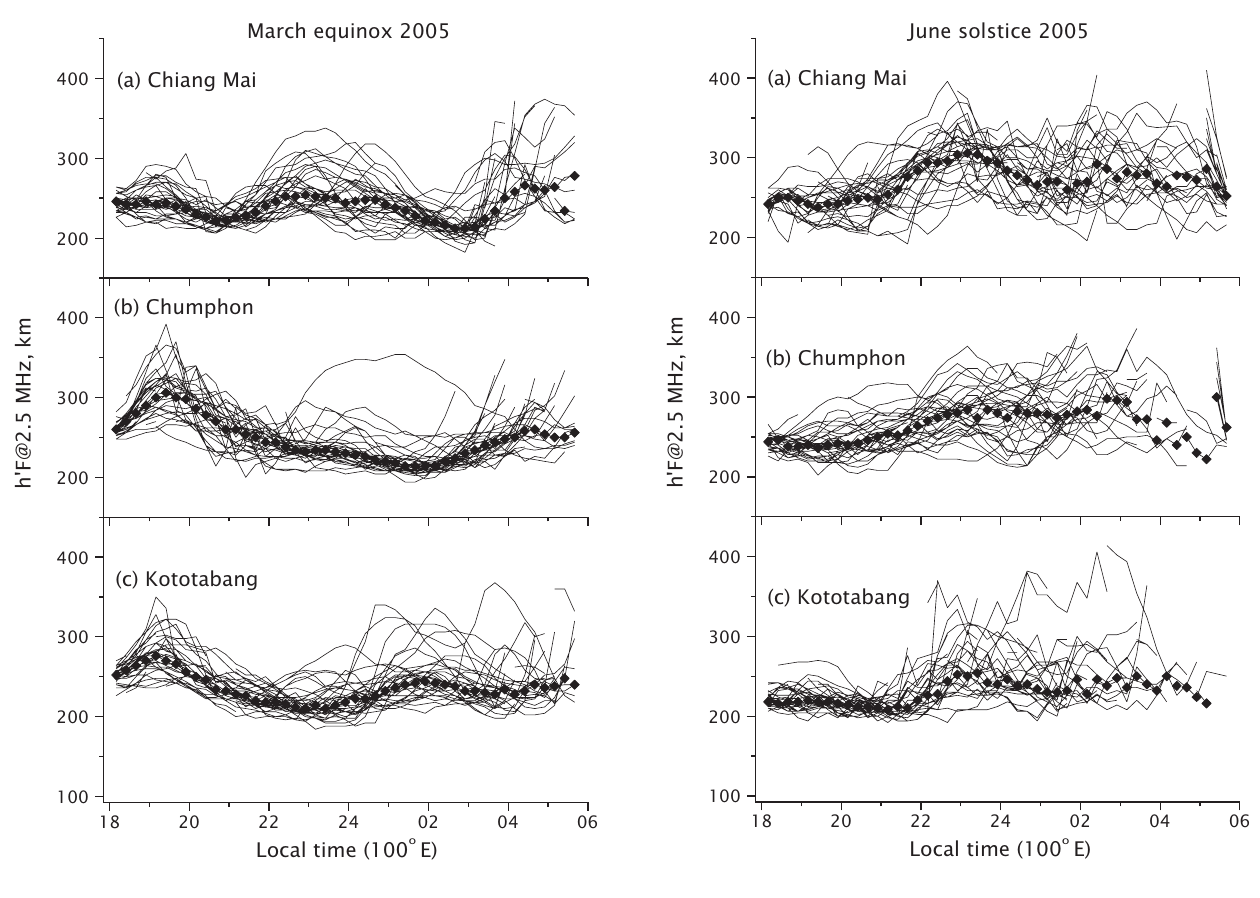
Fig. 7. The same as Fig. 5 but for the period from 5 March to 5 April 2005 (March equinox).